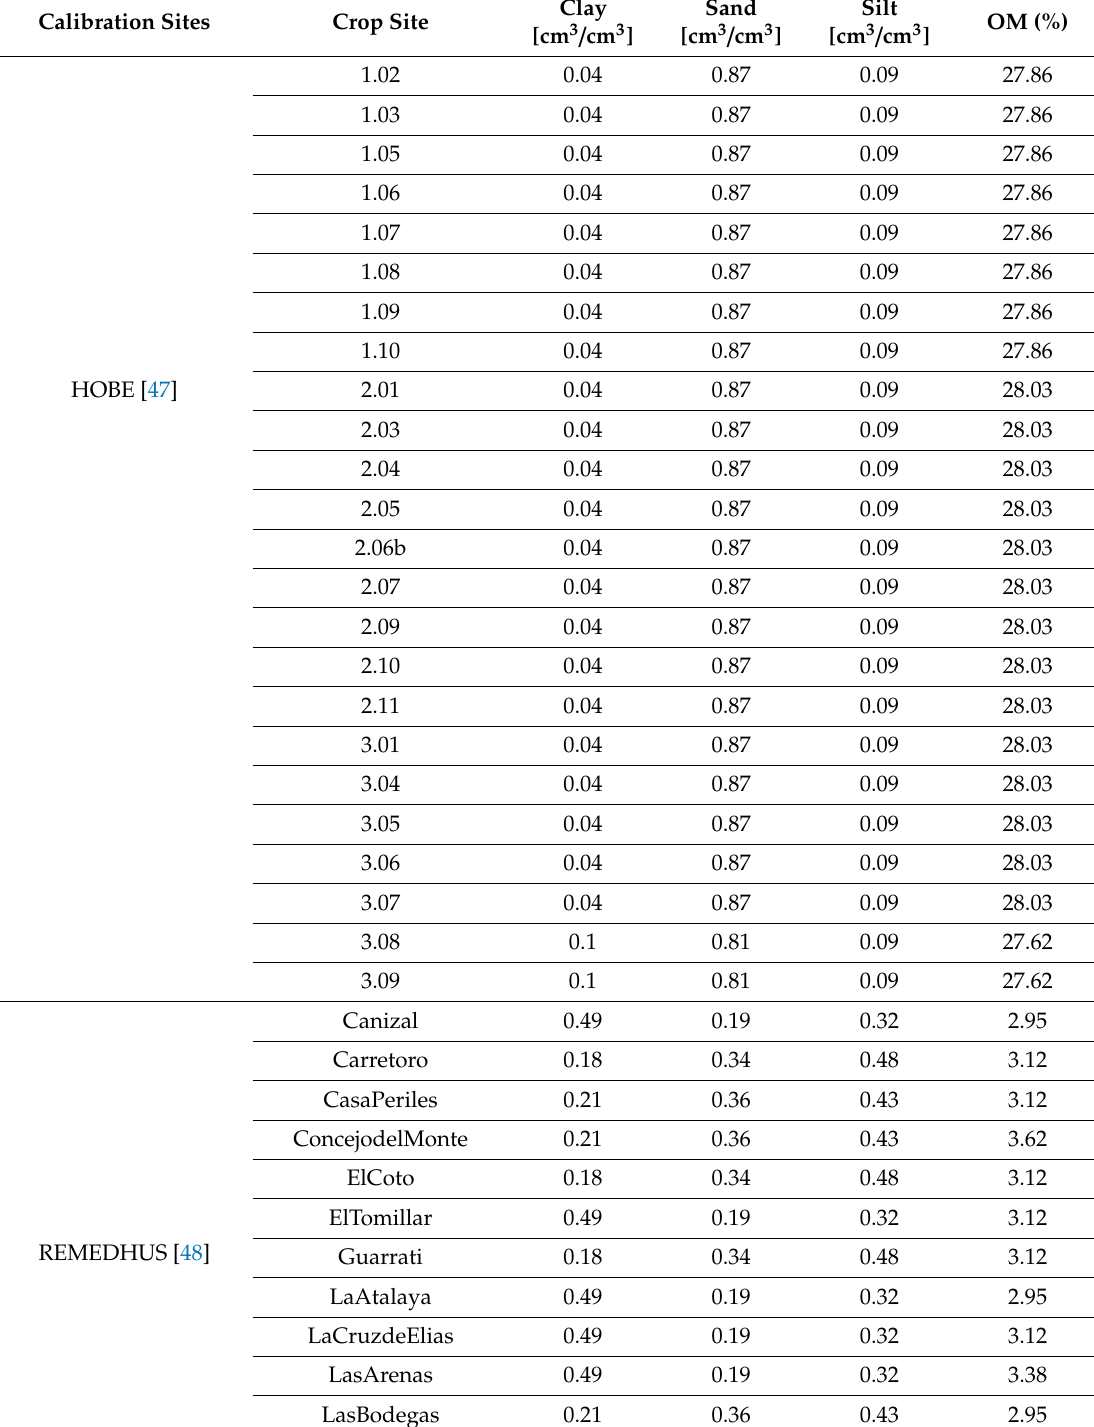
Table A1. Data used for Tb calibration over